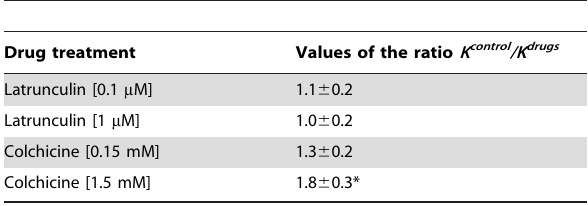
Table 1. Mean values of the ratio between K control and K drugs (latrunculin and